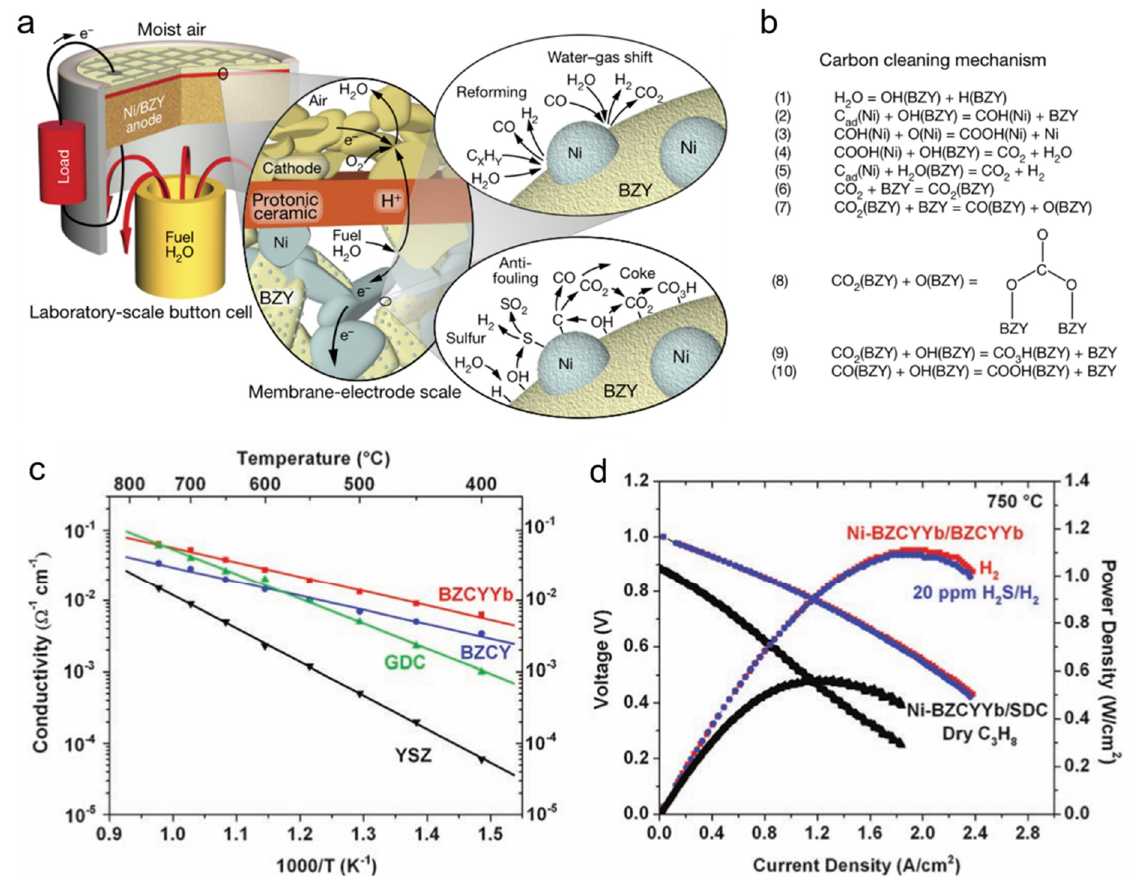
Figure 11. ( a ) Schematic illustration of the protonic ceramic fuel cell (PCFC) and mechanism of hydrocarbon reforming, water-gas shift reaction, sulfur cleaning, and carbon cleaning; ( b ) Mechanism of carbon cleaning. C ad indicates carbon absorbed on the surface of Ni. Reproduced with permission from Ref. [50]. ( c ) Ionic conductivities of BZCYYb, BZCY, GDC, and YSZ measured at 400 to 750 °C in wet oxygen (with ~3 vol % H 2 O). ( d ) Typical current-voltage characteristics and the corresponding power densities measured at 750 °C for a cell with a configuration of Ni-BZCYYb|BZCYYb|BZCY-LSCF when ambient air was used as oxidant and hydrogen as fuel (with or without 20 ppm H 2 S contamination), and for another cell with a configuration of Ni-BZCYYb|SDC|LSCF when dry propane was used as fuel. Reproduced with permission from Ref. [51]. Note BZY: BaZr 0.9 Y 0.1 O 3- δ ; BZCY: Ba(Zr 0.1 Ce 0.7 Y 0.2 )O 3 – δ ; BZCYYb: BaZr 0.1 Ce 0.7 Y 0.1 Yb 0.1 O 3 – δ .